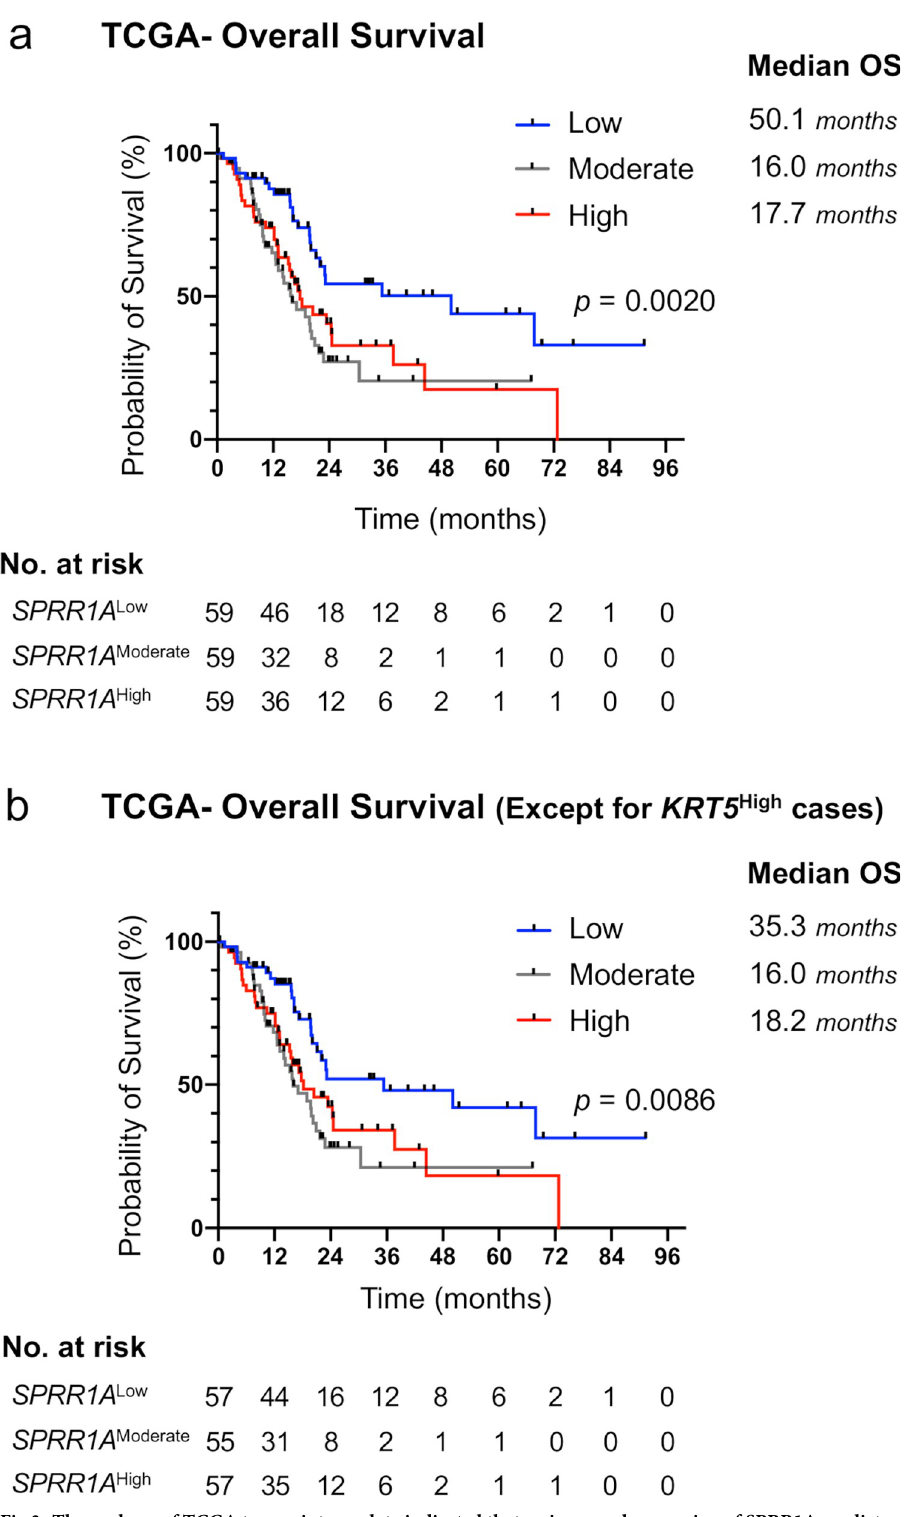
Fig 3. The analyses of TCGA transcriptome data indicated that an increased expression of SPRR1A predicts a poor prognosis in PDAC patients. (a) Kaplan-Meier estimates of the OS stratified by the SPRR1A expression in pancreatic cancers. (b) Kaplan-Meier estimates of the OS stratified by the SPRR1A expression in pancreatic cancer patients, except for those with a high KRT5 expression (dotted line in S3C Fig). Tick marks indicate censored data. Kaplan–Meier estimates were compared using a stratified log-rank